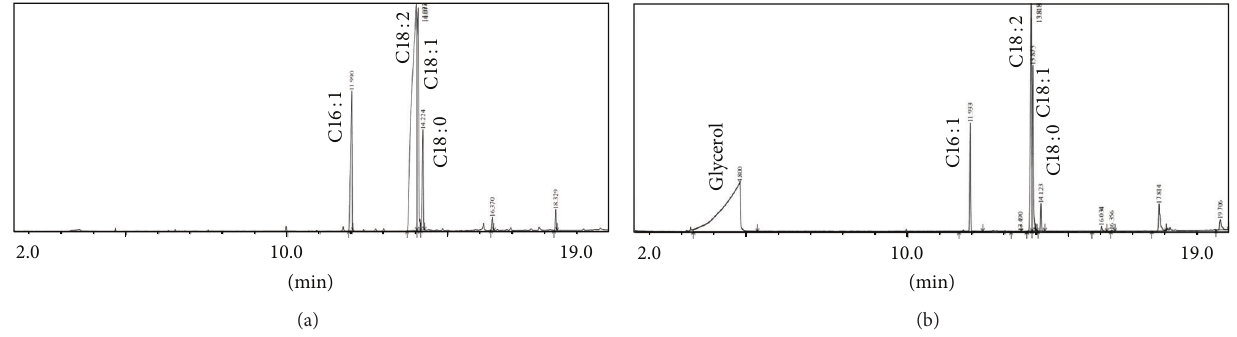
Figure 6: (a) Gas chromatography-mass spectrometry of biodiesel produced at optimum processing conditions using KM micromixer. (b) Gas chromatography-mass spectrometry of biodiesel produced using 48 :1 methanol : oil molar ratio.